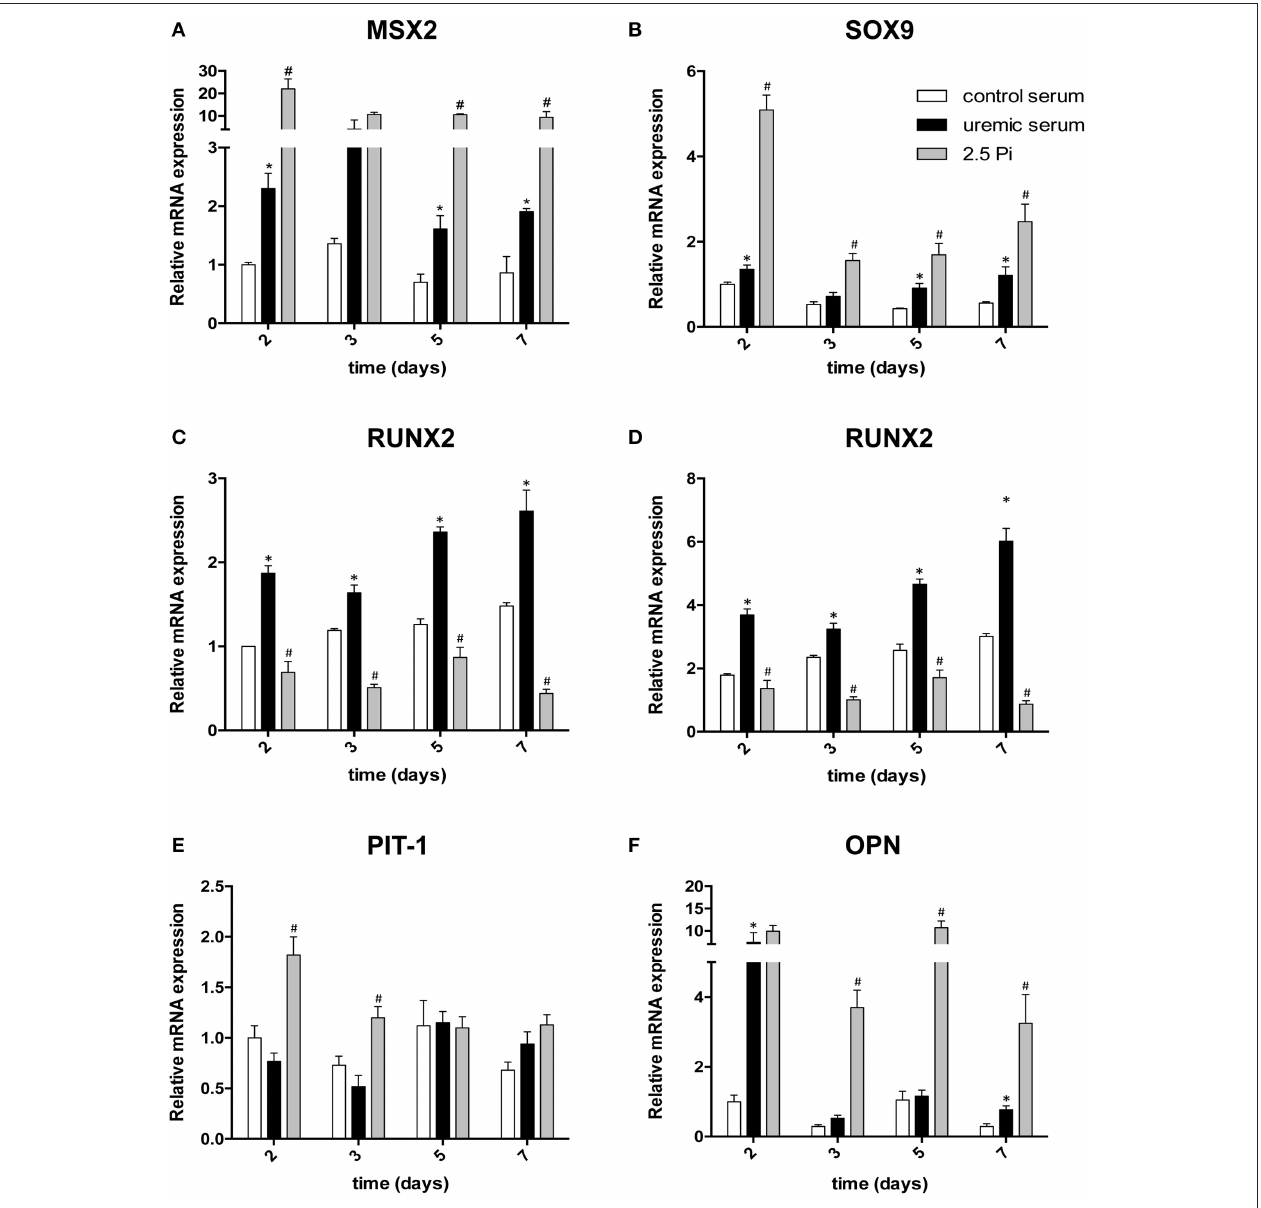
FIGURE 2 | Differential modulation of osteochondrogenic differentiation marker expression in HAMSC treated with high phosphate or uremic serum. Cells were incubated for the indicated times in DMEM with increased Pi and Ca 2 + (2.5 Pi) or in DMEM supplemented with 20% of control or uremic serum. Expression of the indicated osteochondrogenic markers ( A–F ; each individual marker is identified above the corresponding graph) was evaluated with qPCR. The expression of target genes was normalized to GAPDH. Results are presented as the mean ± SE ( N = 3) normalized to expression under control serum conditions on day 2, except for (D) , where data are normalized to day 0. Values were compared using a one-way ANOVA followed by Tukey’s multiple comparisons test. *Significant change vs. control serum; # significant change vs. uremic